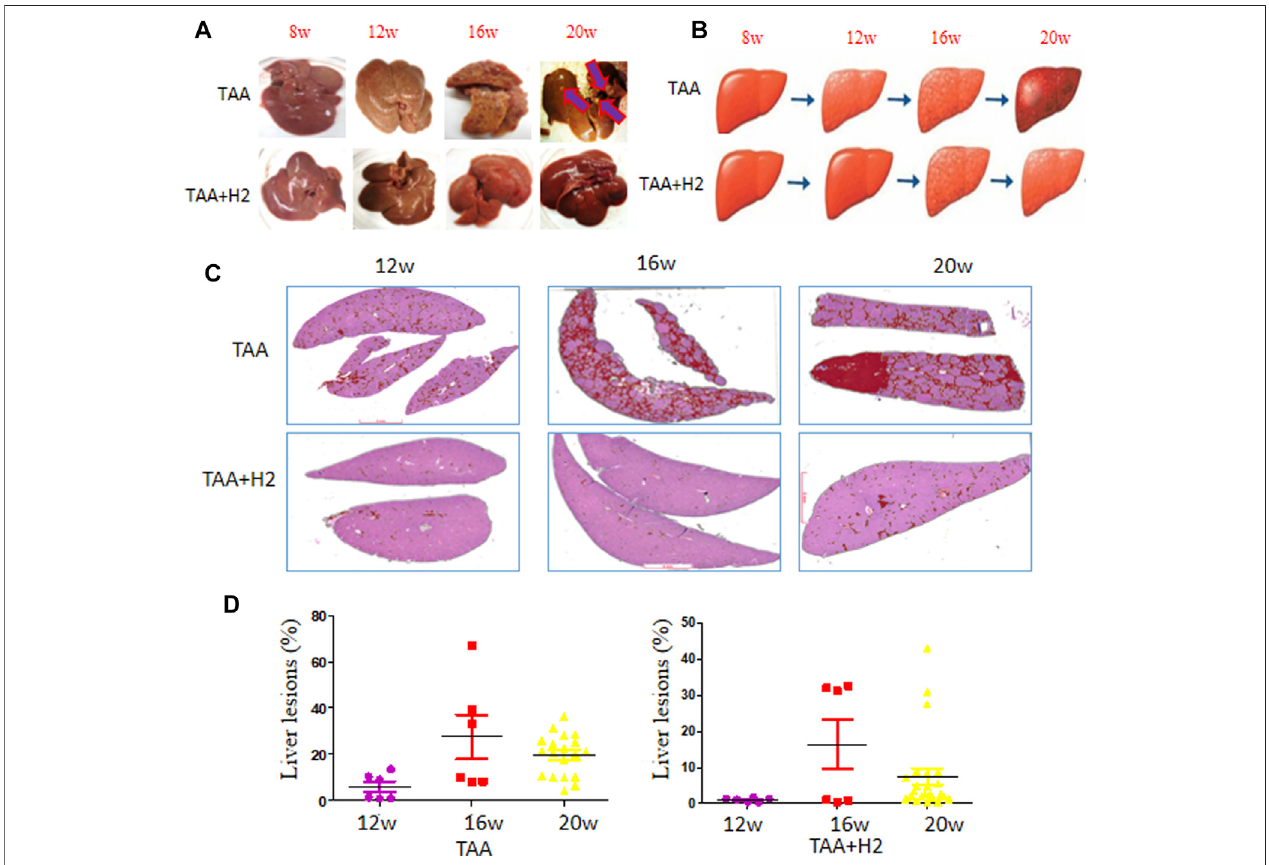
FIGURE3| Microscopic pro fi les ofthe liverlesions during TAAinduction withor withoutH 2 -rich wateradministration. (A) Representative grossimages ofthe livers at theindicatedtime points. (B) Schematic diagram oftheliverstatustreatedwithTAAwithor without hydrogen-rich water supplementation. (C) Representativeimages ofcholangiolar lesions oftheliversat the indicatedtimepoints analyzedbytheAIalgorithm. (D) The ratioofcholangiolar lesions ofthelivers assessed bytheAIalgorithm on representative slides at the indicated time points.